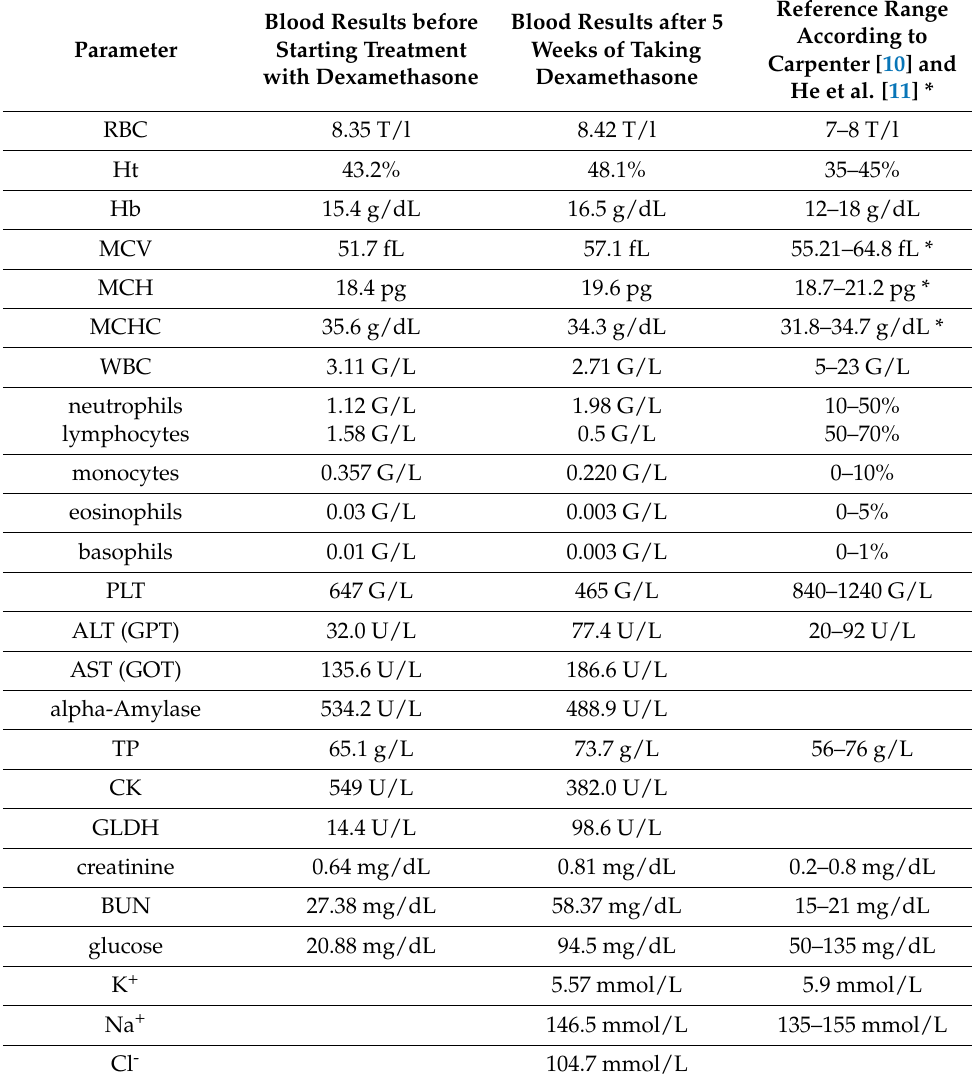
Table 1. Blood results and reference